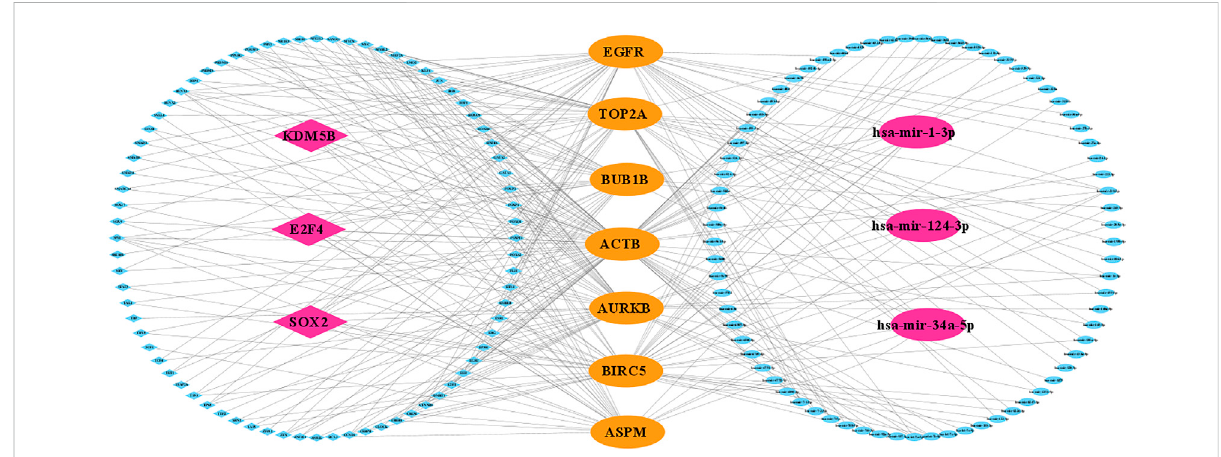
FIGURE 7 KG-regulatory (TF and miRNA) interaction network, where yellow indicates KGs and pink indicates key TFs (diamond) and key miRNAs